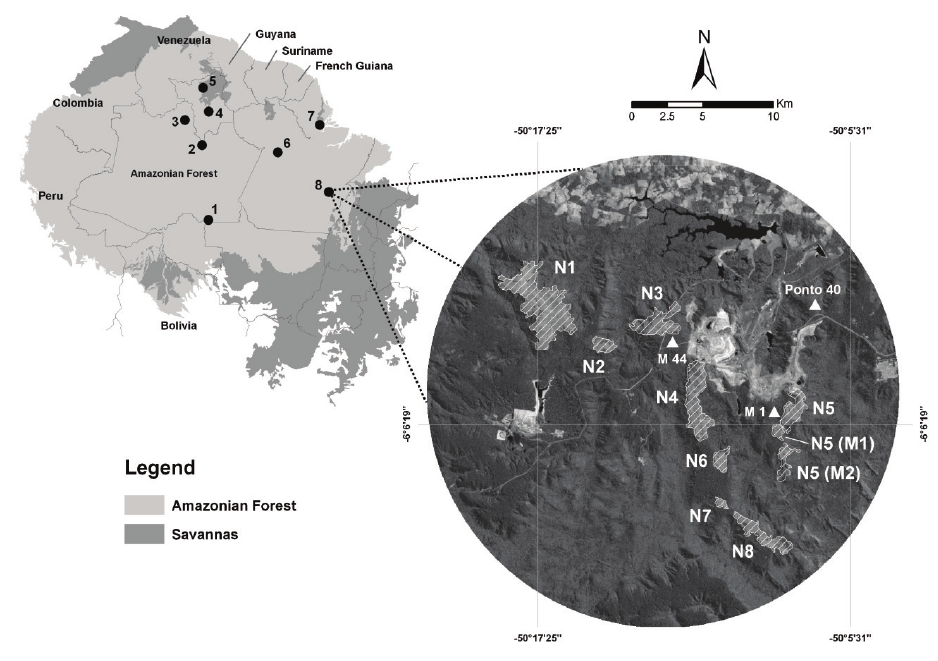
Figure 1 - Study sites at Carajás National Forest and the locations of bird inventories in open